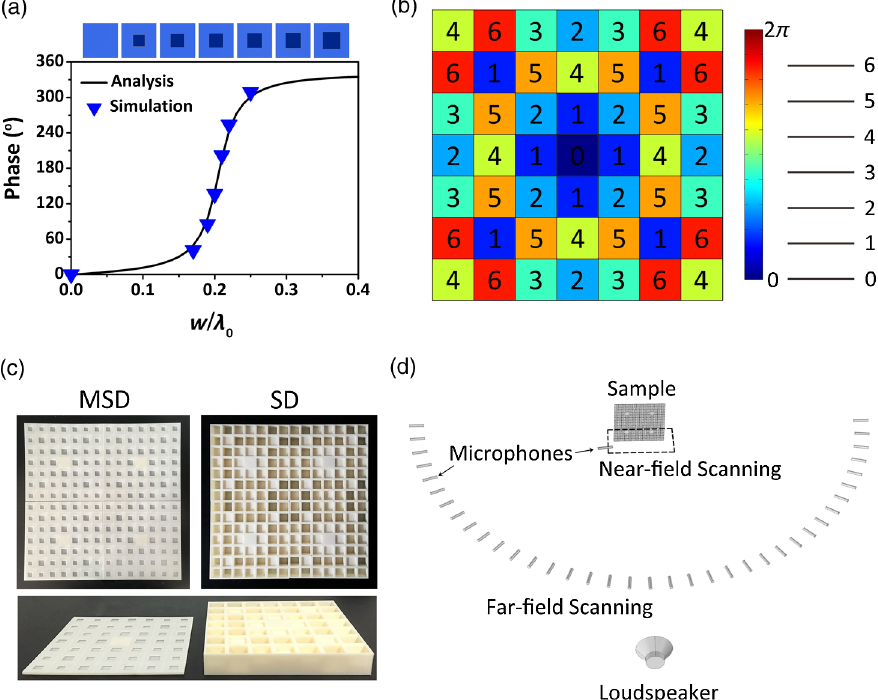
FIG. 2. Design of the metasurface-based Schroeder diffuser. (a) The analytical and simulated relationship between the phase shift and the geometrical parameter w of the MSD at the center frequency of f 0 ¼ 6860 Hz. The triangles represent the discrete points for generating the phase of 0 – 2 π × 6 = 7 with a step of 2 π × 1 = 7 , corresponding to numbers 0 – 6 in (b). (b) The design of a 2D MSD based on a 2D quadratic residue sequence. One period consists of 7 × 7 unit cells. (c) The photographs of the 3D printed samples of MSD and SD with 2 × 2 periods of QRS, viz., 14 × 14 unit cells. (d) The schematic diagram of the experimental